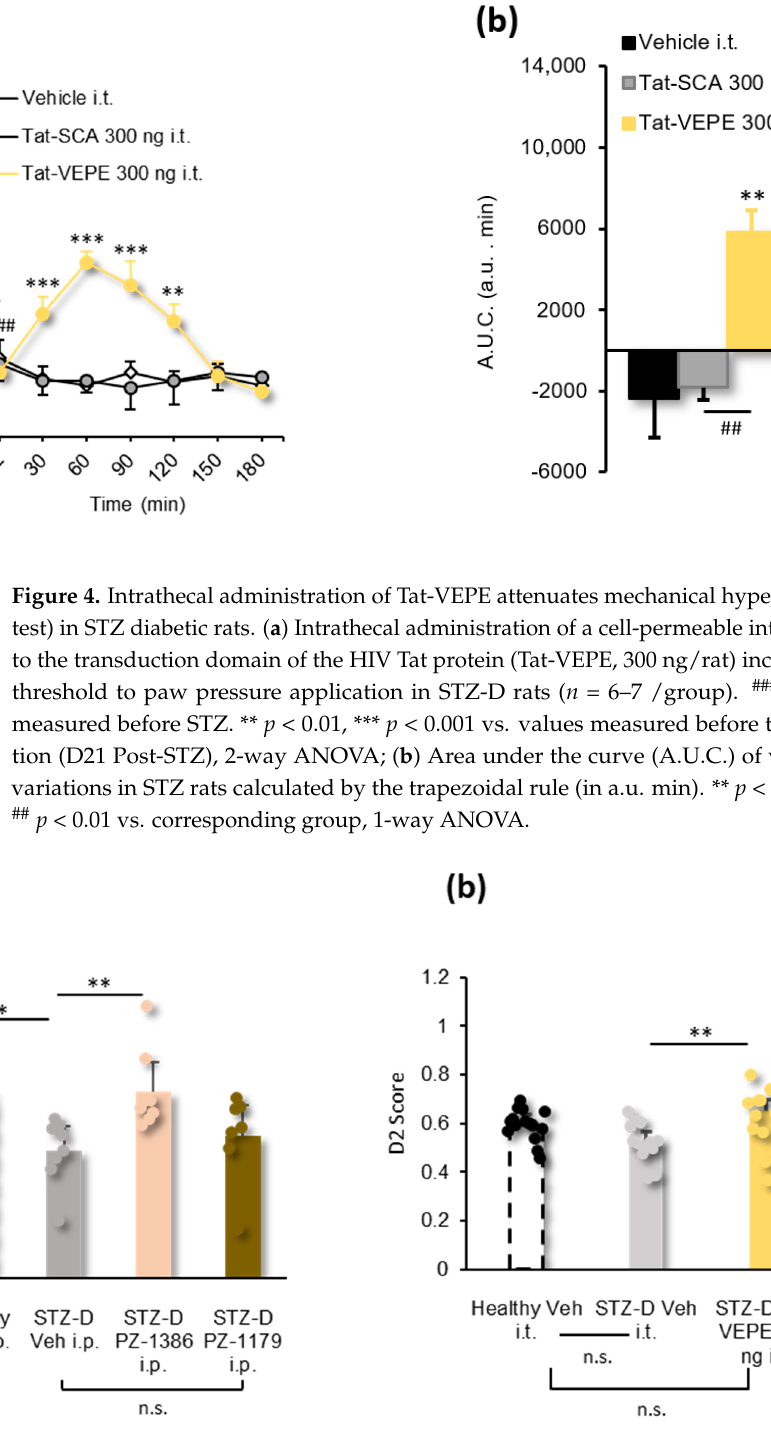
Figure 5. Effect of blocking the constitutive activity of 5-HT 6 receptor or disrupting 5-HT 6 -mTOR interaction on cognitive deficits (novel object recognition test) induced by diabetic neuropathic pain in rats. ( a ) Intraperitoneal injection of PZ-1386 (25 µ mol/kg) but not PZ-1179 (25 µ mol/kg), or vehicle (Veh, water for injections), and ( b ) intrathecal injection of Tat-VEPE (300 ng/rat), improves novelty discrimination in STZ diabetic (STZ-D) rats ( n = 7–16/group). * p < 0.05, ** p < 0.01, vs. STZ-D Vehicle group, 1-way ANOVA.